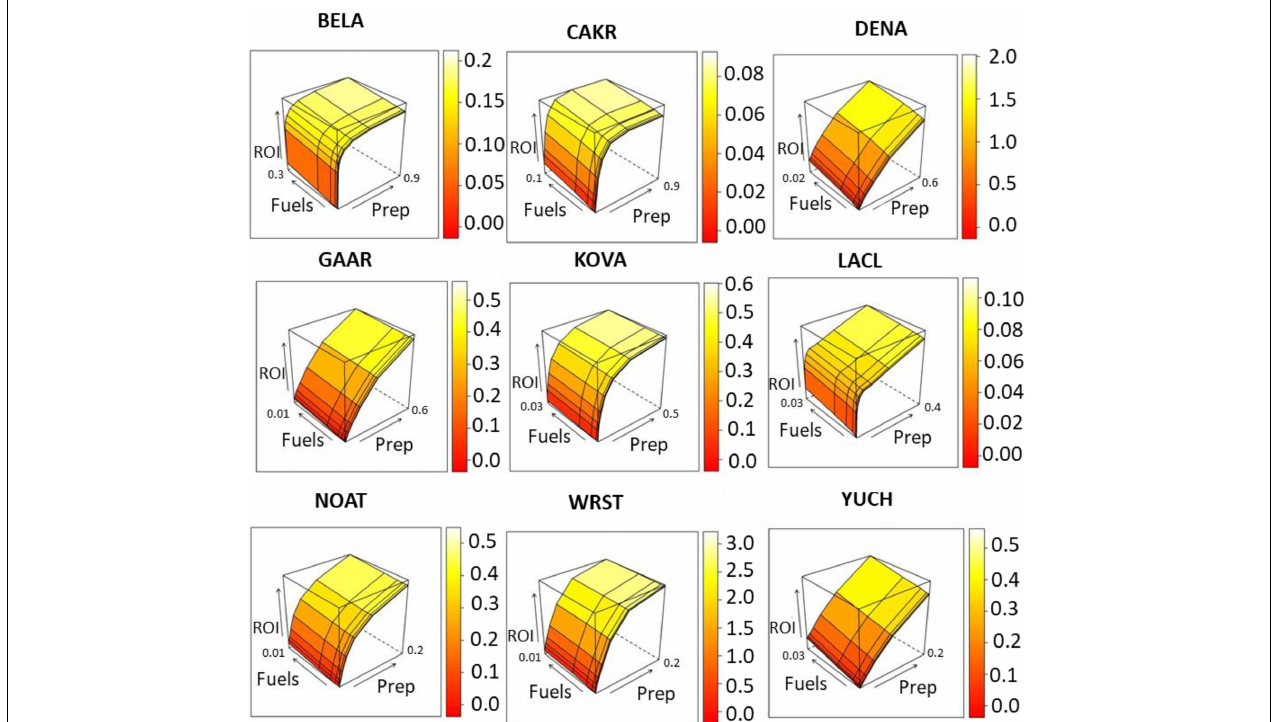
FIGURE 4 | Program surfaces for the Alaska Fire Management Zone. Preparedness budgets are represented by the x-axis and fuels budgets are represented by the y-axis . Both budgets are measured by million USD ($); ROI is depicted by the z-axis , with ROI increasing as the surface changes from red to yellow. The program surface shows all possible preparedness and fuels budget combinations and their respective ROI. The STARFire-generated results are represented by the points where the preparedness and fuels budget lines cross and the areas in between are interpolated.